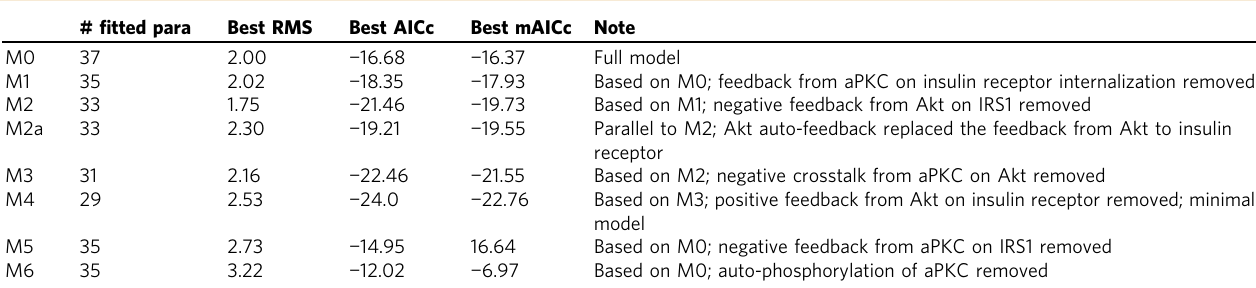
Table 1 Summary of the tested